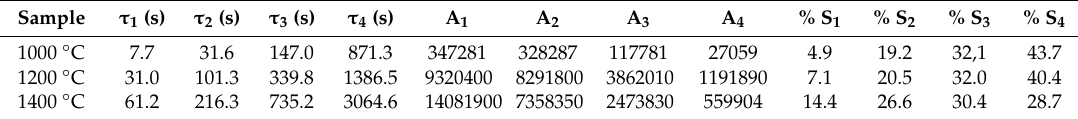
Table 2. The fitting results of the decay parameters and the fractional contributions of the lifetime components (i.e., τ 1 , τ 2 , τ 3 , and τ 4 ). A 1 , A 2 , A 3 , and A 4 are constants, and S 1 , S 2 , S 3 , and S 4 represent the % of each